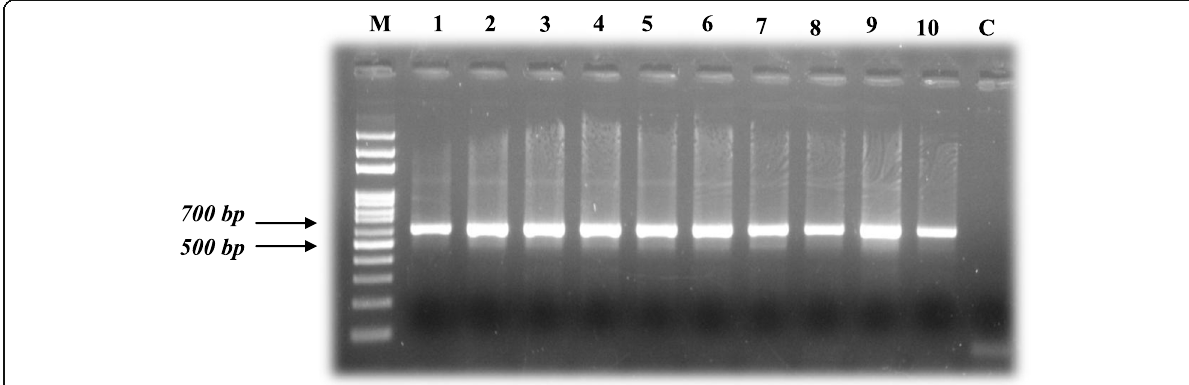
Fig. 2. PCR amplification of ochratoxigenic isolates in dried grapes samples. Lanes 1 to 6, 8 and 9: A. carbonarius ; Lane 7: Aspergillus niger ;